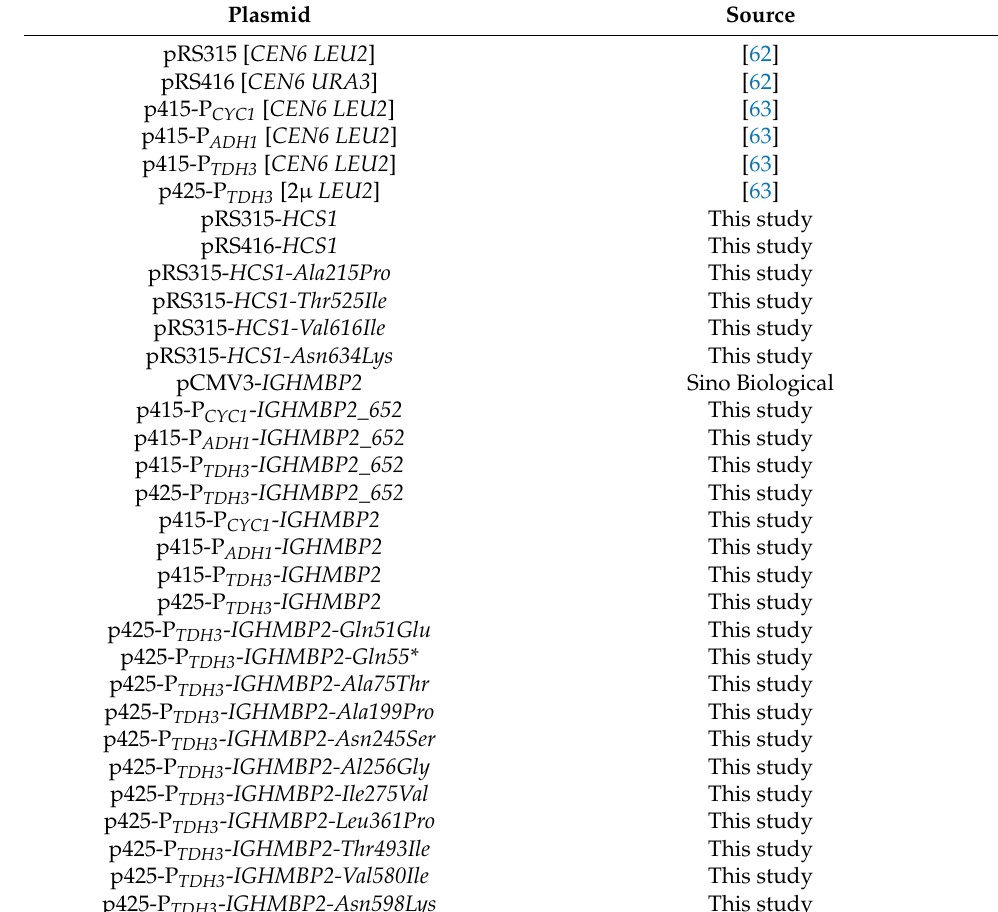
Table 3. Plasmids used in this